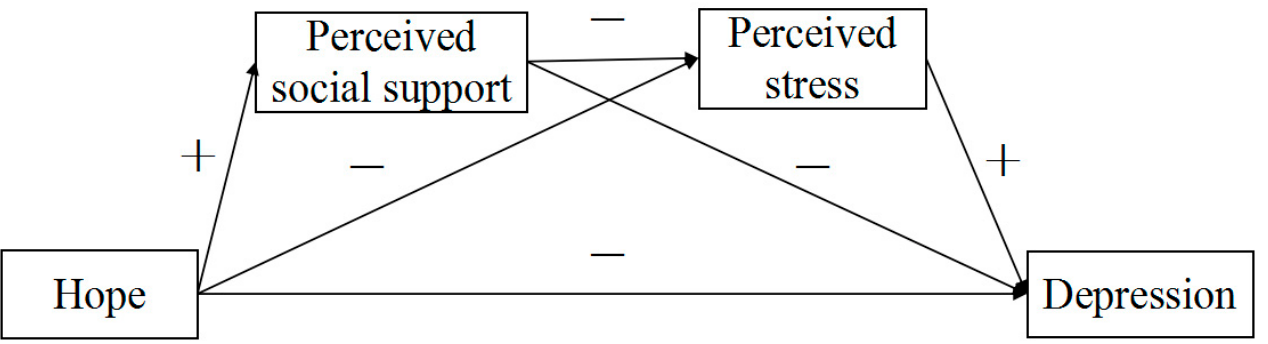
Figure 1. The proposed model.